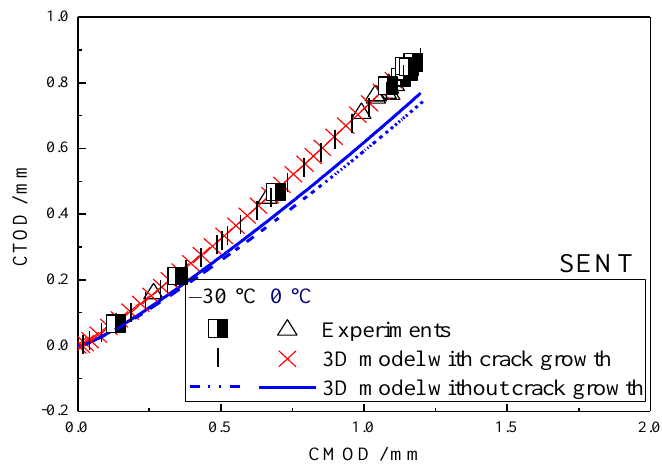
Figure 12. Effect of crack growth on the CTOD vs. CMOD relations for the SENT specimens under 0 °C and 30 °C.